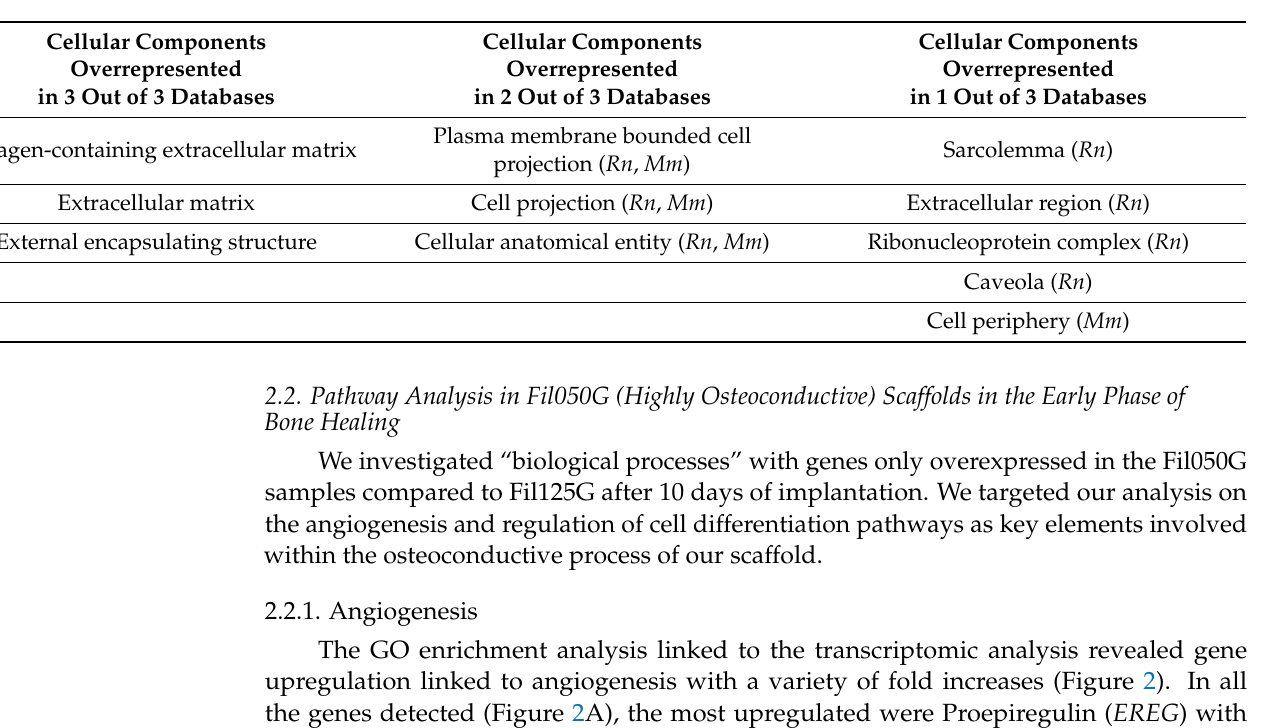
Table 4. Selected GO “cellular component” terms significantly overrepresented solely in Fil050G after 10 days of implantation in the Homo sapiens ( Hs ), Mus Musculus ( Mm ), and Rattus Norvegicus ( Rn )